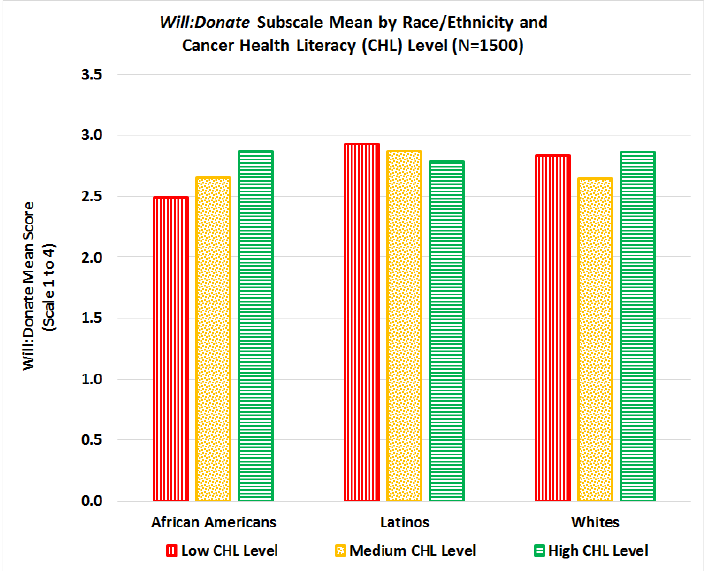
Figure 10. Interaction between cancer health literacy and race/ethnicity on Will:Donate subscale mean score.